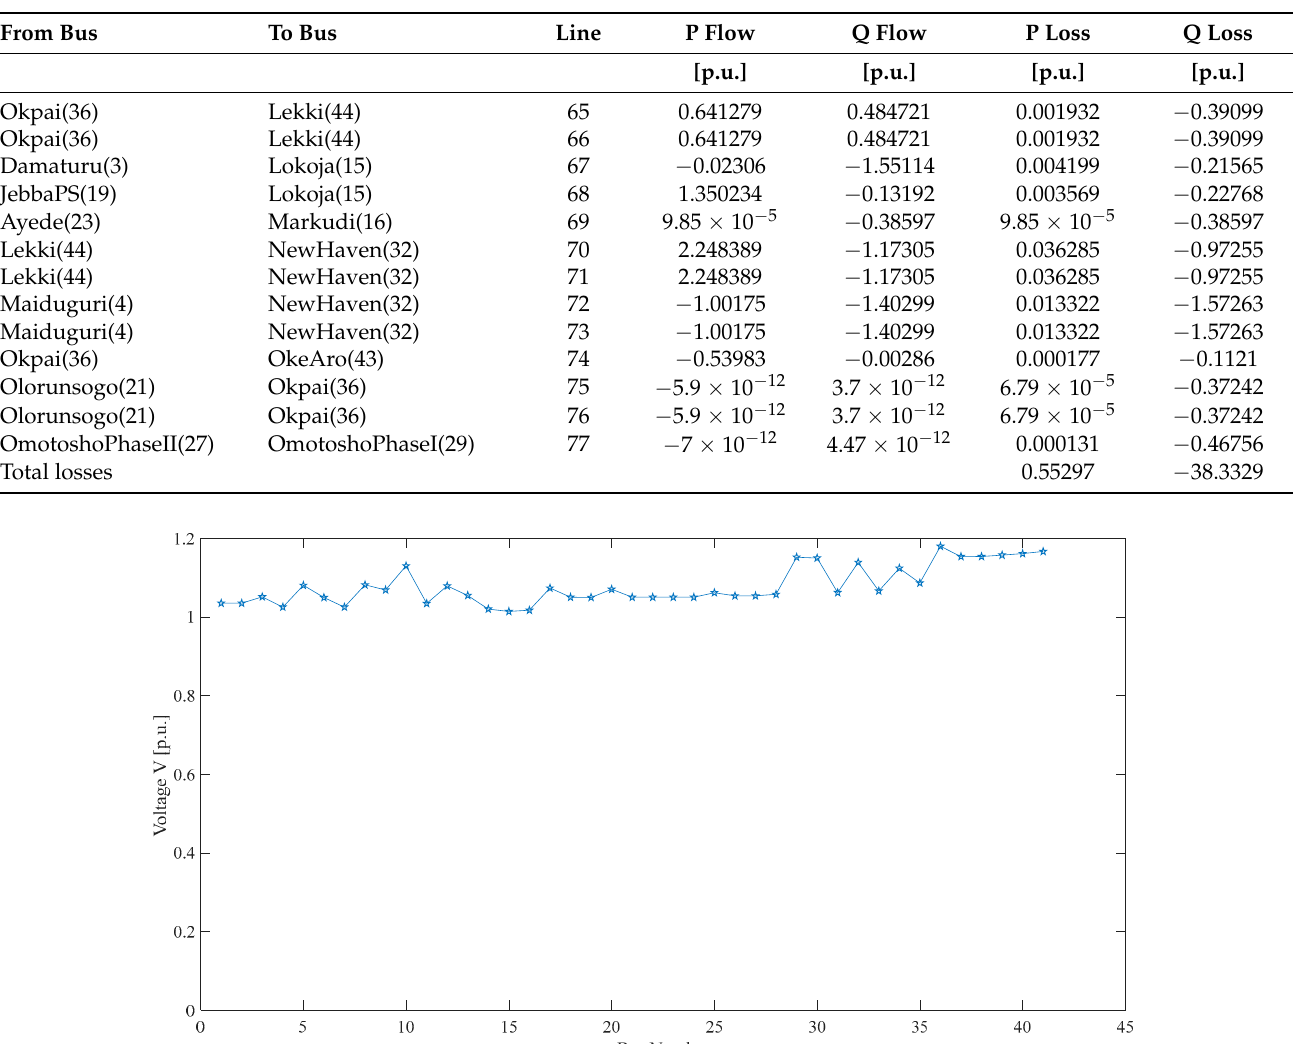
Figure 7. Voltage profile of the compensated Nigerian 41 bus transmission network with IPFC.